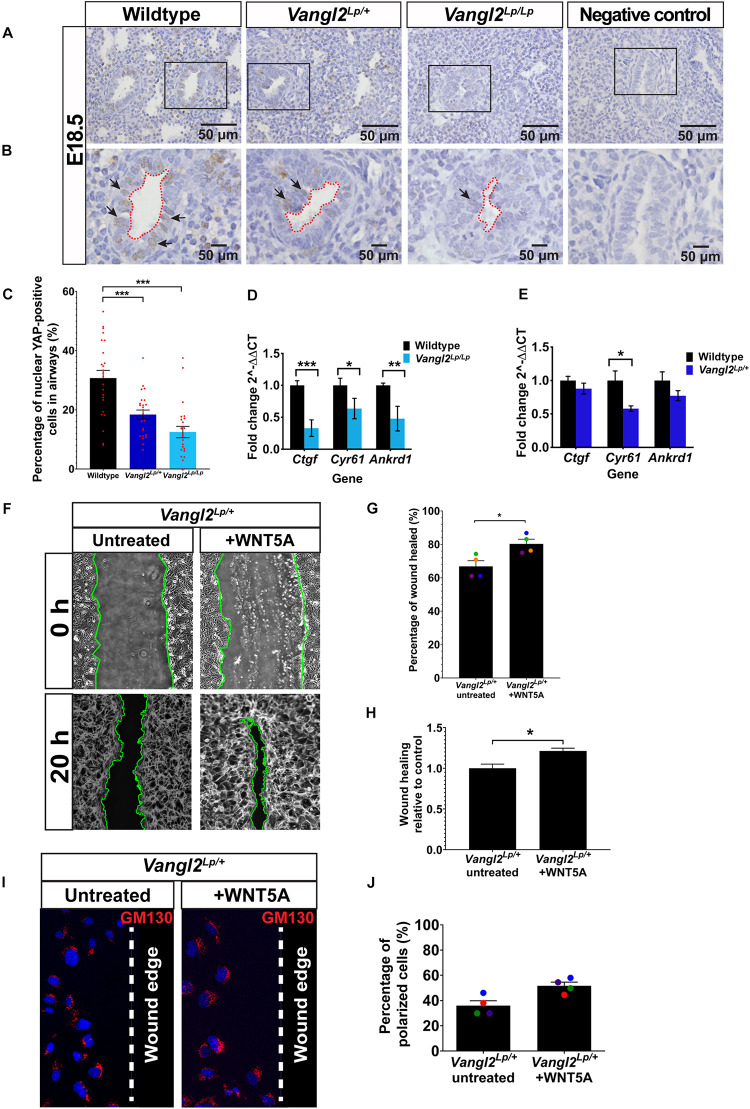
Reduced YAP signaling in embryonic Vangl2Lp airways and WNT5A rescues cell migration defects in Vangl2Lp/+. (A,B) Representative images show immunostaining for YAP in E18.5 wildtype, heterozygous Vangl2Lp/+, and homozygous Vangl2Lp/Lp mouse lungs. Sections were counterstained with hematoxylin. Negative controls with primary antibody omitted are shown. Insets (B) show the morphology of airway lumen. Arrows indicate nuclear YAP staining. (C) Percentage of nuclear YAP-positive cells in the airways. n = 3 mice per group; eight airways were quantified per mouse; a total of 1389 cells (wildtype), 1381 cells (Vangl2Lp/+), and 995 cells (Vangl2Lp/Lp) were analyzed (presented as mean ± SEM); one-way ANOVA with Tukey’s post hoc test, ***p < 0.001. Histograms show transcript levels for YAP target genes: Ctgf, Cyr61, and Ankrd1 in E18.5 wildtype vs Vangl2Lp/Lp
(D) and adult wildtype vs Vangl2Lp/+ lungs (E). n = 3 independent experiments; three mice per genotype; each experiment was run in triplicate. Data are presented as mean ± SEM; Mann–Whitney U-test, *p < 0.05, **p < 0.01, ***p < 0.001. (F) Representative images showing untreated and WNT5A-treated Vangl2Lp/+ TECs at 0 and 20 h post-scratch. Wound edges are indicated by green lines. Percentage of wound healed 20 h after wound scratch in untreated Vangl2Lp/+ TECs and Vangl2Lp/+ TECs treated with WNT5A (G) and wound-healing rate in WNT5A-treated Vangl2Lp/+ TECs in relative to untreated Vangl2Lp/+ TEC controls (H). Data are presented as mean ± SEM. n = 4 independent experiments; TECs from three mice were pooled for each group per experiment; three technical replicates for each group per experiment; each dot represents mean percentage of wound healed per experiment. Mann–Whitney U-test, *p < 0.05. (I) Immunostaining for Golgi marker (GM130; red) in fixed untreated and WNT5A-treated Vangl2Lp/+ TECs 20 h post-scratch to determine cell polarity at leading edge. Nuclei were labeled with DAPI (blue) and dotted line indicates the wound edge. (J) Percentage of polarized cells 20 h post-scratch in untreated and WNT5A-treated Vangl2Lp/+ TECs (presented as mean ± SEM). n = 4 independent experiments; TECs from three mice were pooled for each group per experiment; three technical replicates for each group per experiment. Mann–Whitney U-test.